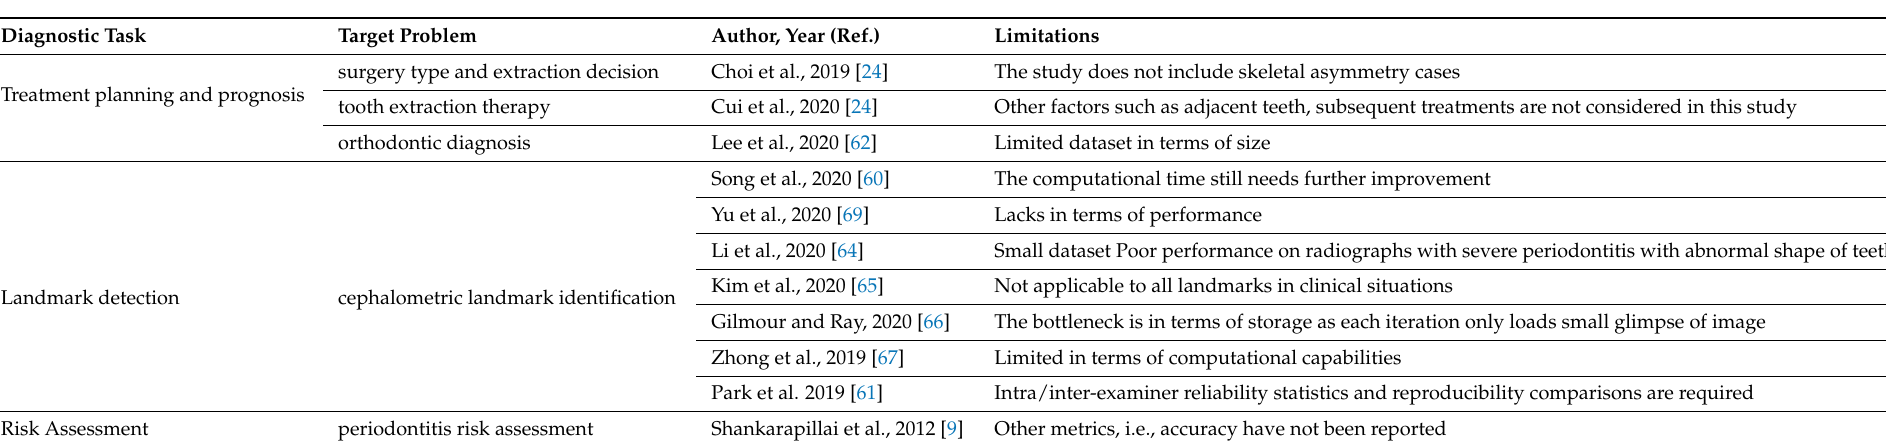
Table 9. Limitations of relevant studies employing AI for different treatment planning, landmark detection, and risk